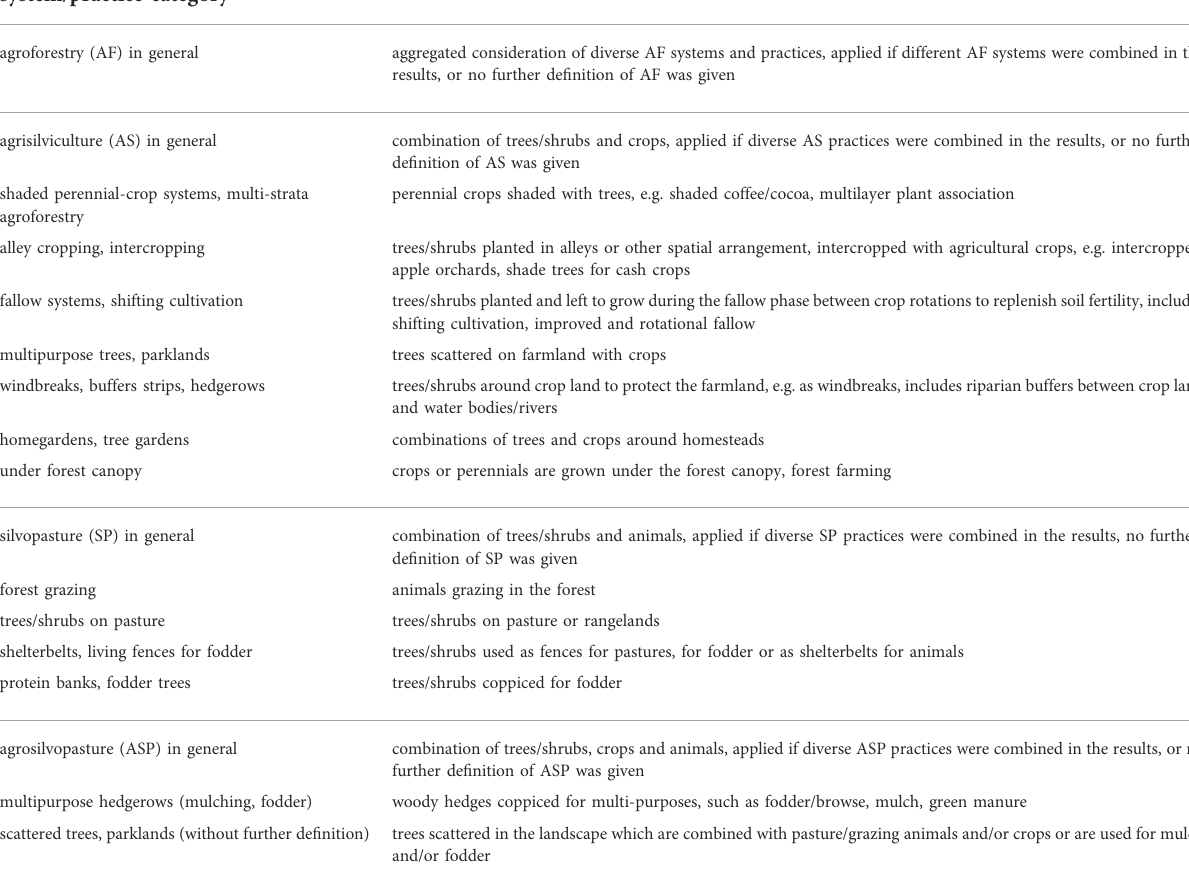
TABLE 1 Categorization of agroforestry systems and practices. Speci fi c practices are assorted to the aggregated categories of agroforestry, agrisilvicultural, silvopastoral, and agrosilvopastoral systems. Agroforestry system/practice